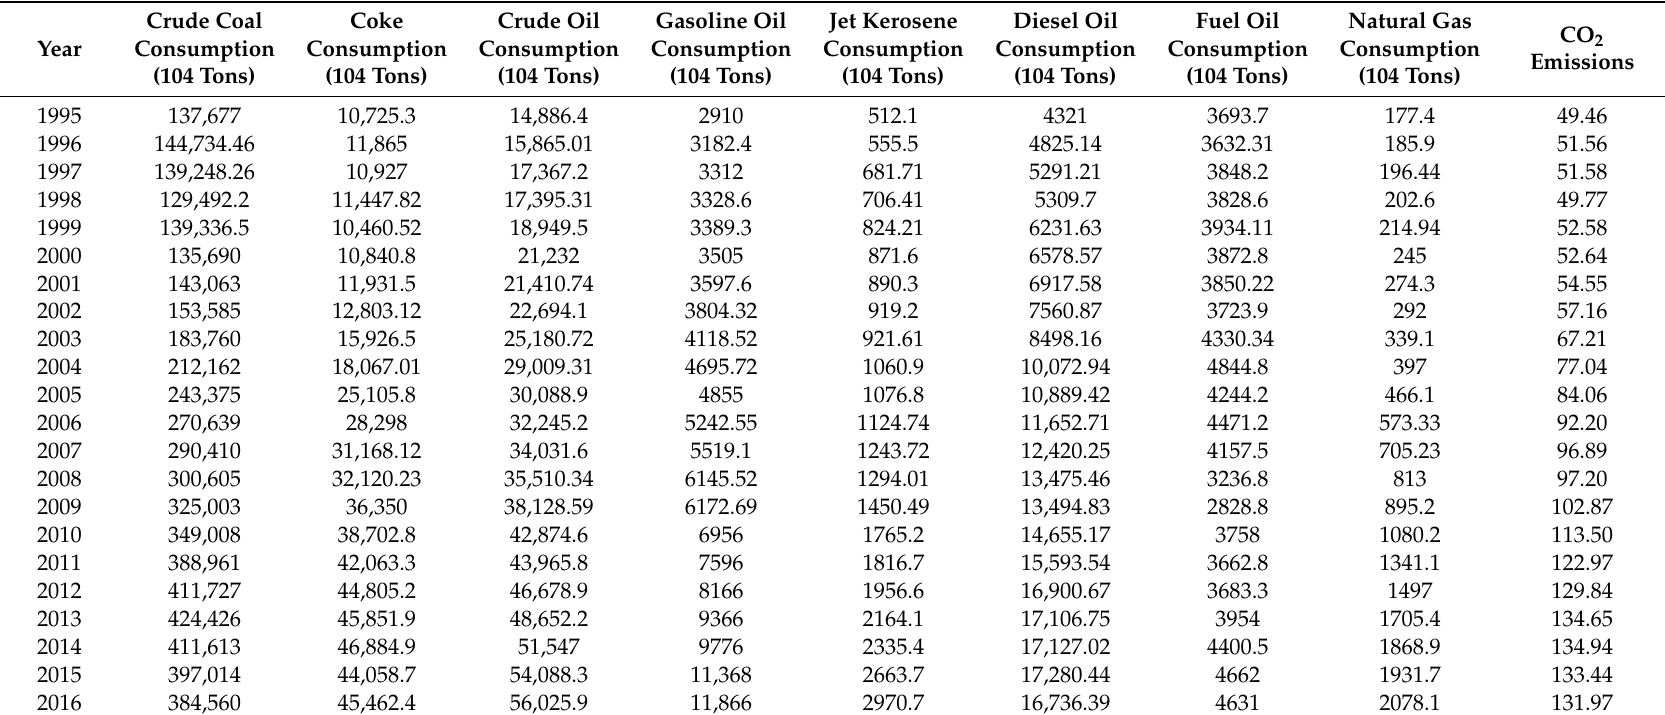
Table 4. Energy consumption and CO 2